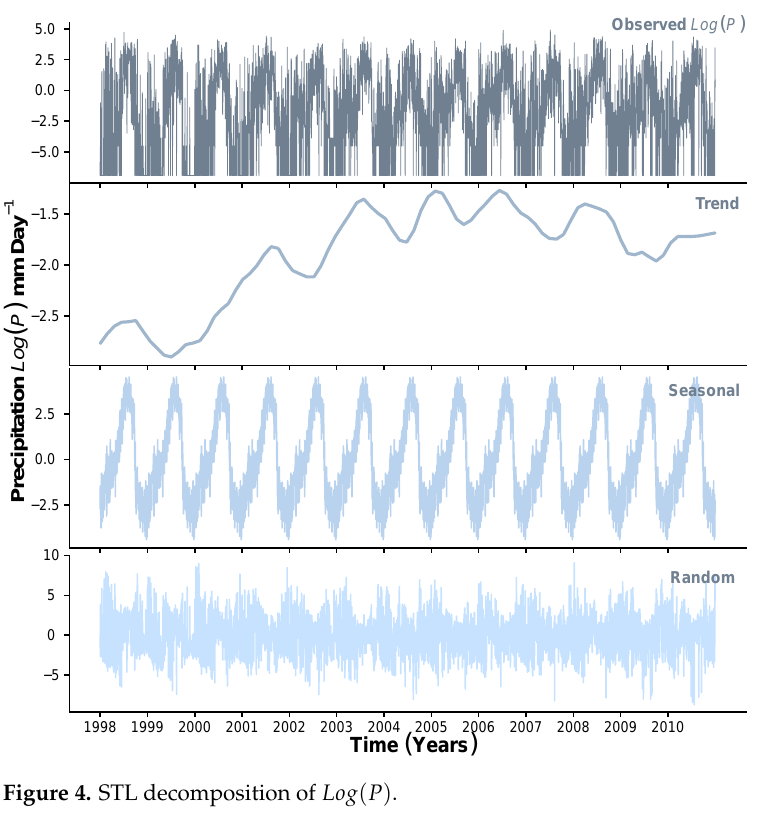
Figure 4. STL decomposition of Log ( P ) .